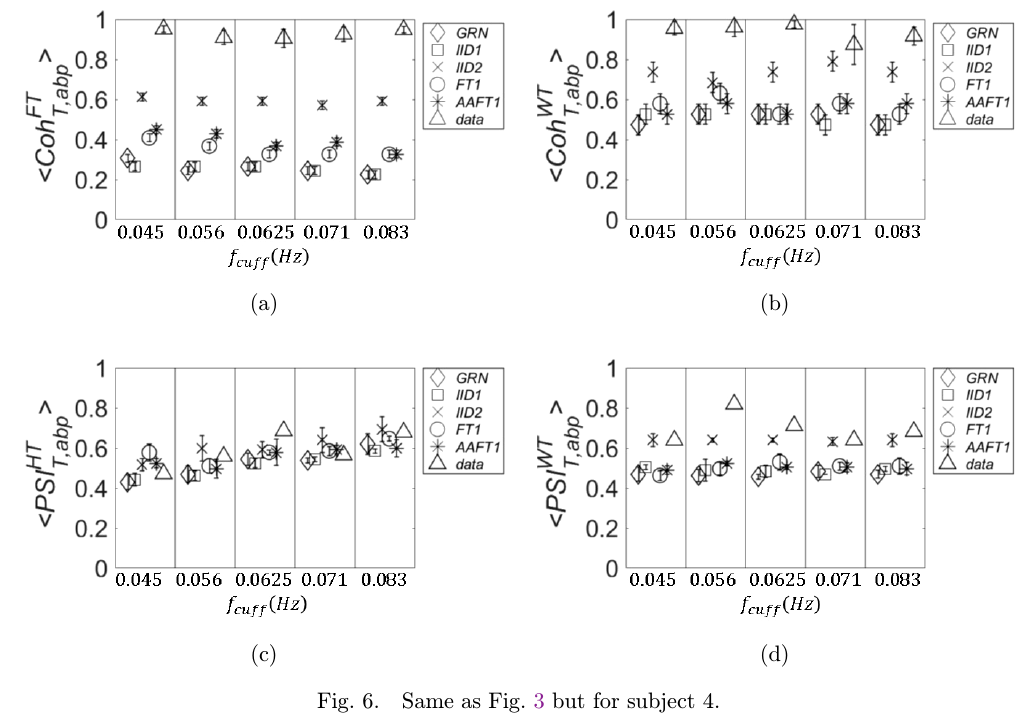
Fig. 6. Same as Fig. 3 but for subject 4.